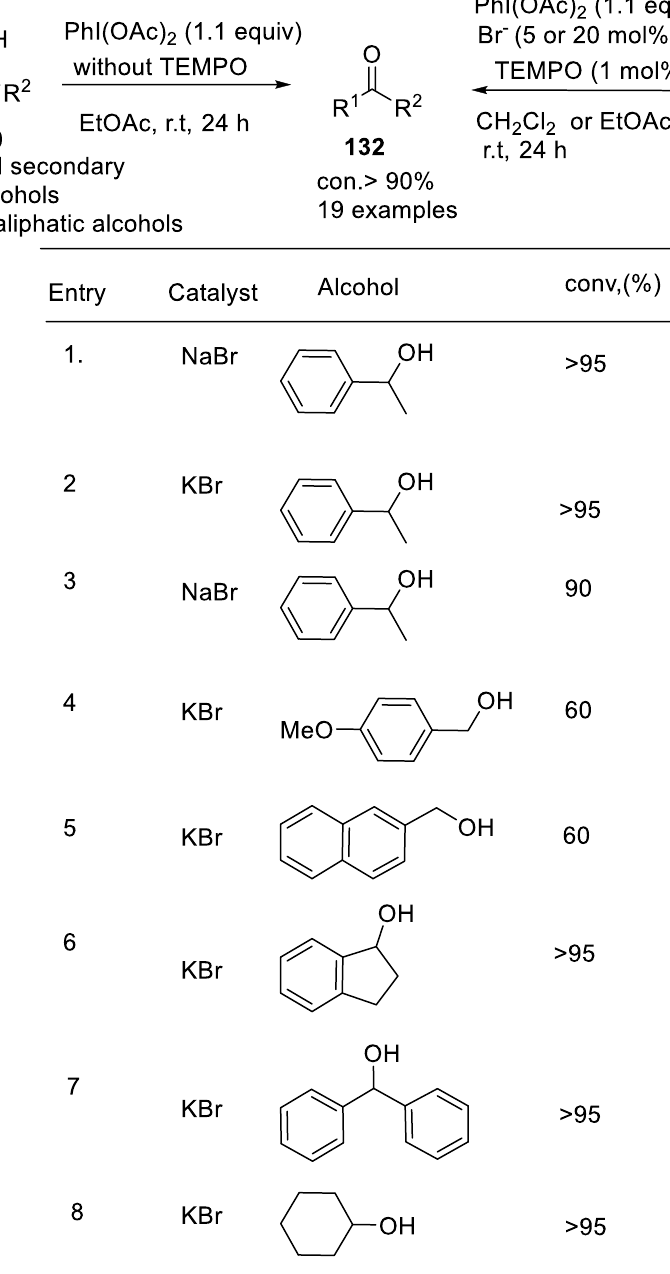
The creation of bis(acyloxy)bromate(I) anions, which in turn release acetyl hypo- bromite (AcOBr) and potassium acetate (Figure 18, pathways a and b), explains how bromide ions promote reactions in the presence of PIDA. The carbonyl molecule is pro- duced via oxidation mediated by AcOBr (route c), while the initial bromide salt is produced by proton exchange between acetate and HBr (path d). The extra pathways e-i can be used to explain how primary aliphatic alcohols are oxidized with PIDA, TEMPO, and